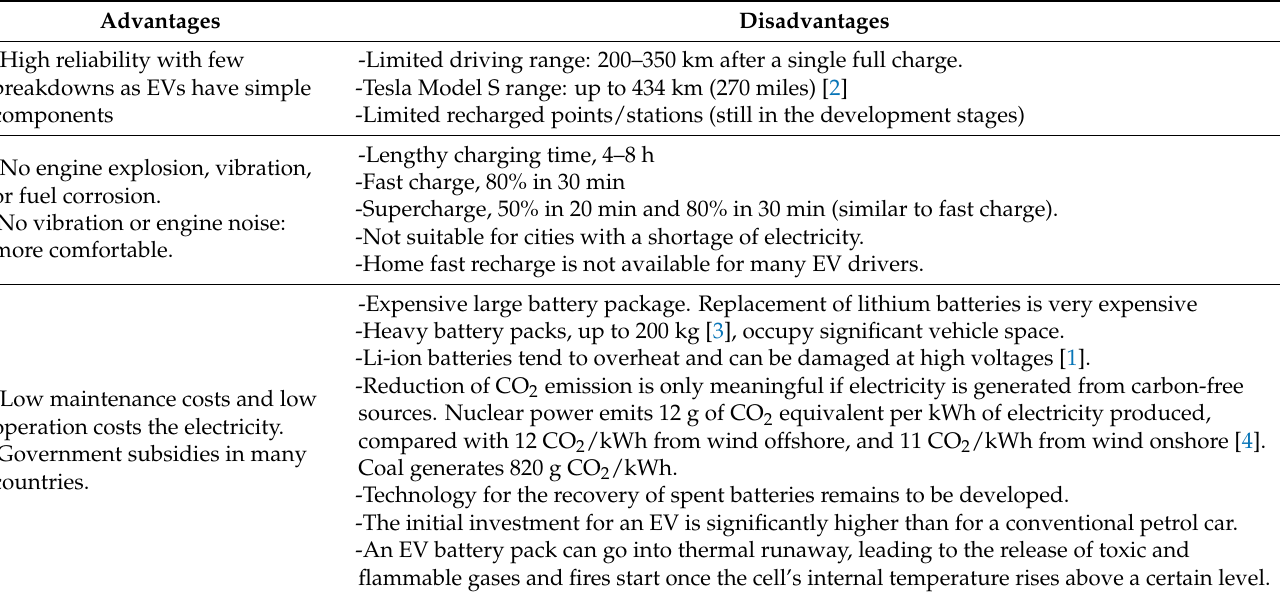
Table 1. Key advantages and disadvantages of